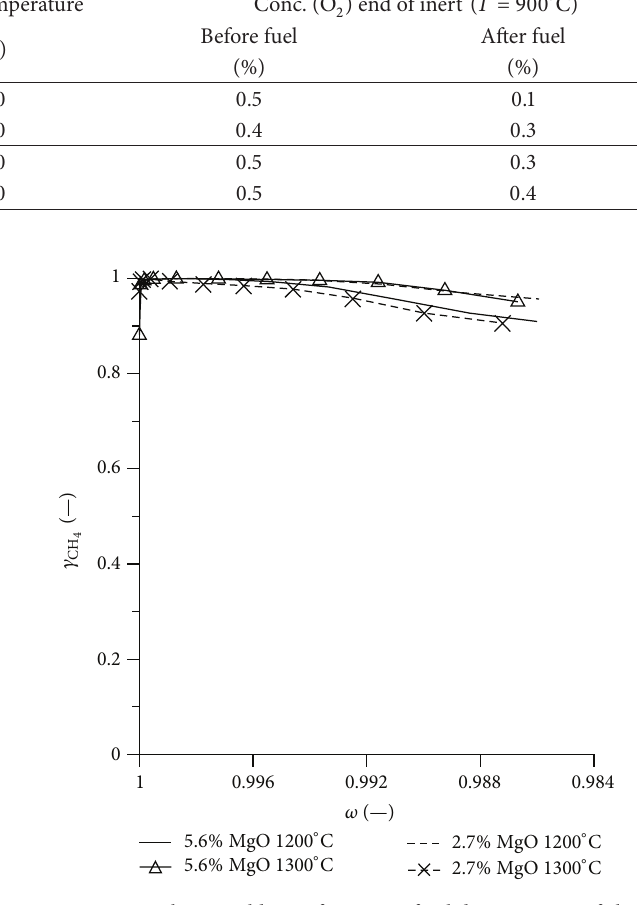
Figure 6: Methane yield as a function of solid conversion of the second methane cycle at 950 ∘